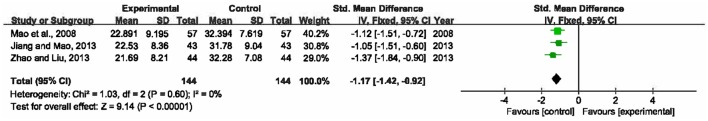
Forest plot of LPS improvement in sepsis patients treated with XBJ+UTI therapy and UTI alone.